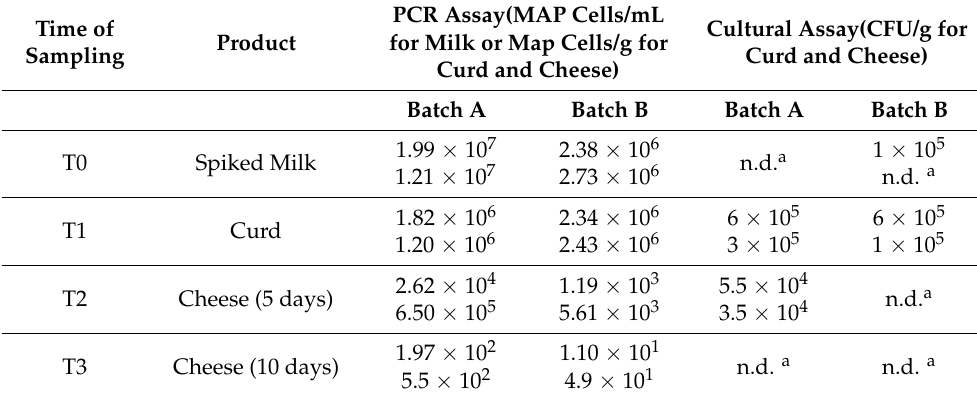
Table 1. MAP load carried out in duplicate on 5 mL of milk and 5 g of curd and cheese by qPCR and by cultural assay on 7H10 agar during the cheese manufacturing process of Batch A and Batch